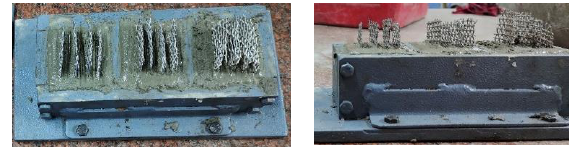
Figure 3. Cubical specimen cast.